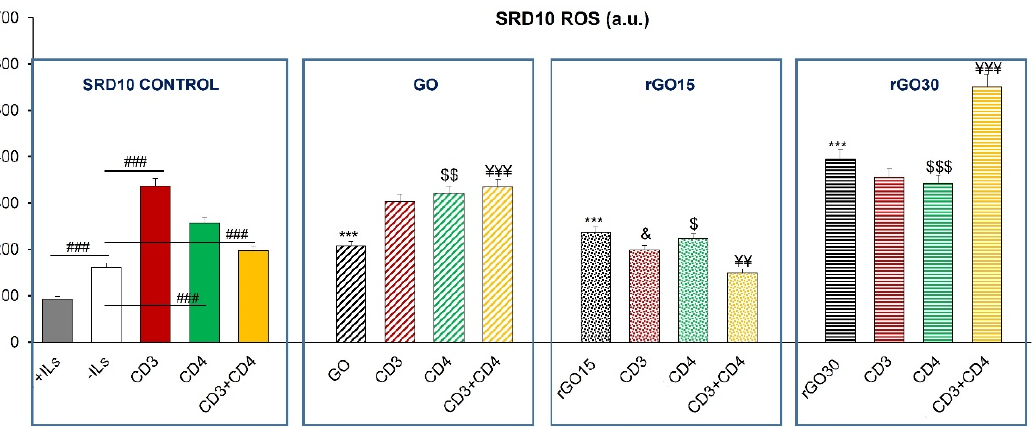
Figure 7. Effect of GO, rGO15 and rGO30 on the intracellular content of reactive oxygen species (ROS) of CD4 + Th2 SR.D10 cell line after 24 h of treatment with 5 µg/mL of these nanostructures, evaluated by flow cytometry under basal and stimulated conditions. The control cells were cultured in the presence of stimuli without material (SR.D10 CONTROL) in parallel. Statistical significance: ### p < 0.005 (compared to control cells without material cultured in the absence of ILs); *** p < 0.005 (compared to control cells without material cultured in the absence of ILs); & p < 0.05 (compared to control cells activated through CD3 in the absence of ILs); $ p < 0.05, $$ p < 0.01, $$$ p < 0.005 (compared to control cells activated through CD4 in the absence of ILs); ¥¥ p < 0.01, ¥¥¥ p < 0.005 (compared to the control cells activated through CD3 and CD4 in the absence of ILs).